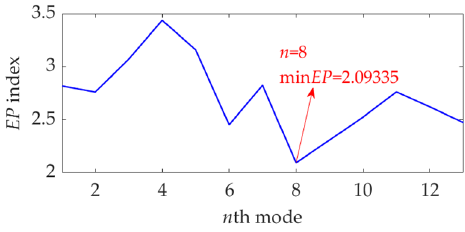
( b ) Figure 20. The optimal target mode: ( a ) time − domain waveform and ( b ) SES. Now, we further use the VMD method to decompose the dataset in this case. Ac- cording to the preceding analysis, we set the number of modes as 13 and the balancing parameter as 6650. In fact, this set of values is also a set of relatively optimal values for VMD, which has been validated by the linear search method mentioned previously. Among the results, the target mode is the fourth mode, as Figure 21a shows, and its SES